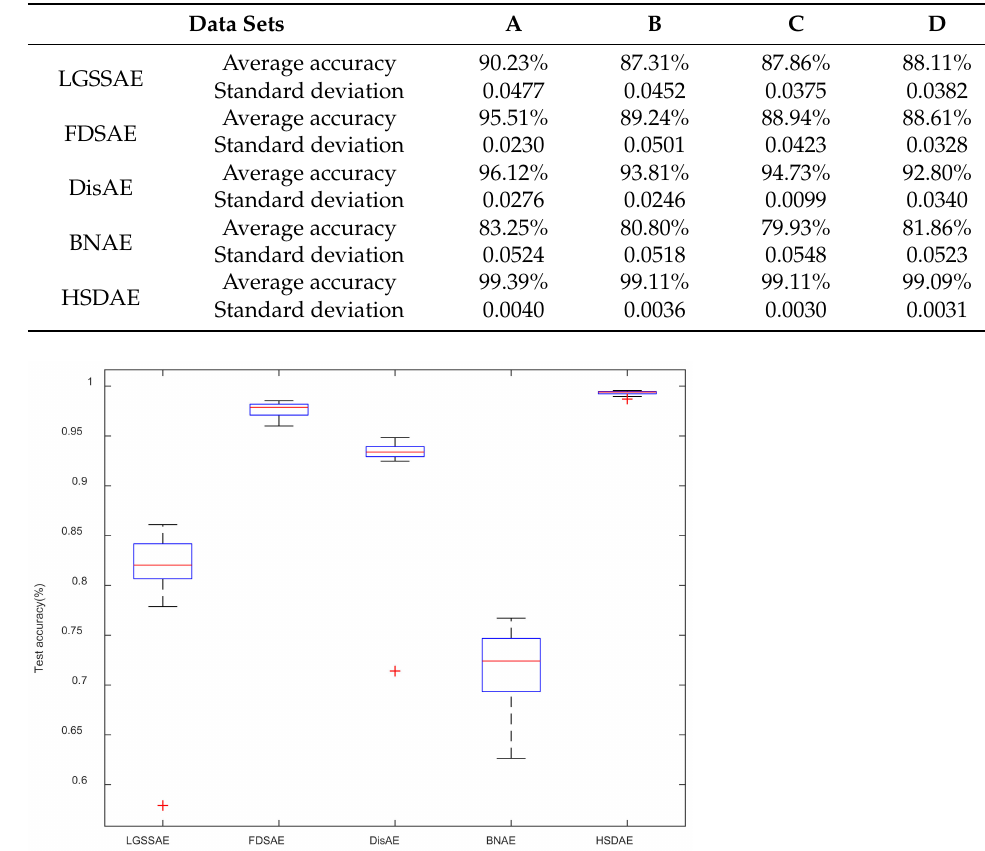
Table 3. The experimental results of different comparison methods in the CWRU data set.